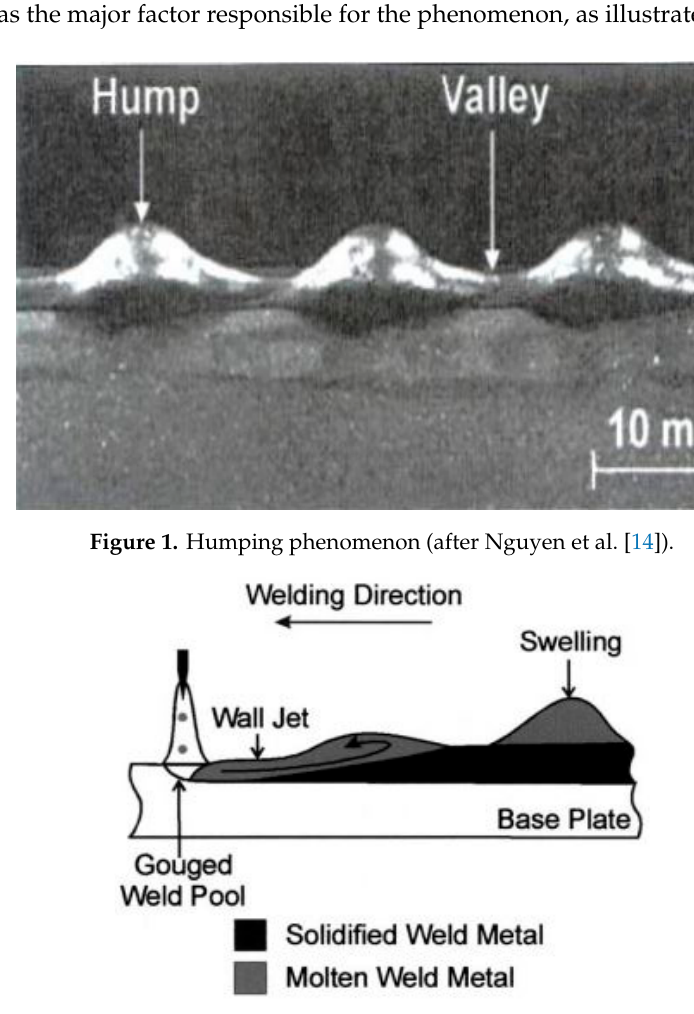
Figure 2. Humping formation (after Nguyen et al.